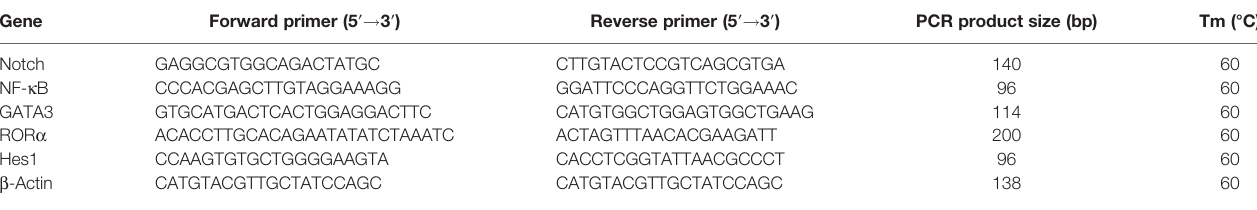
TABLE 2 | Primers for